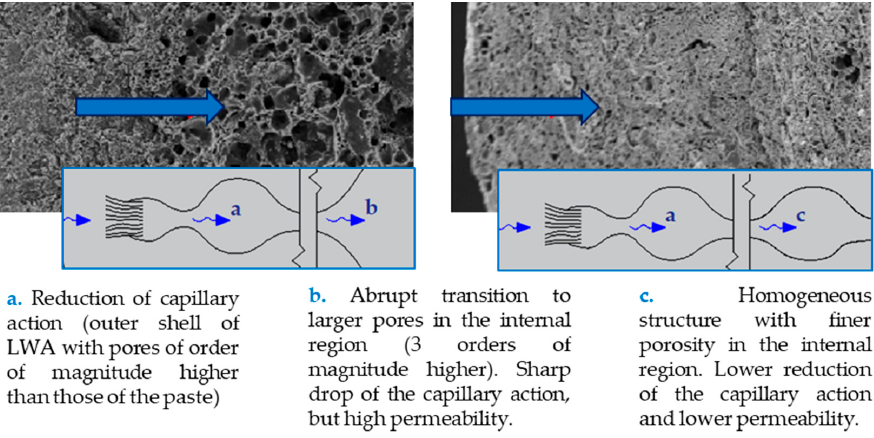
Figure 3. Schematic representation of the transition of porosity between aggregate and matrix (adapted from [29]) .